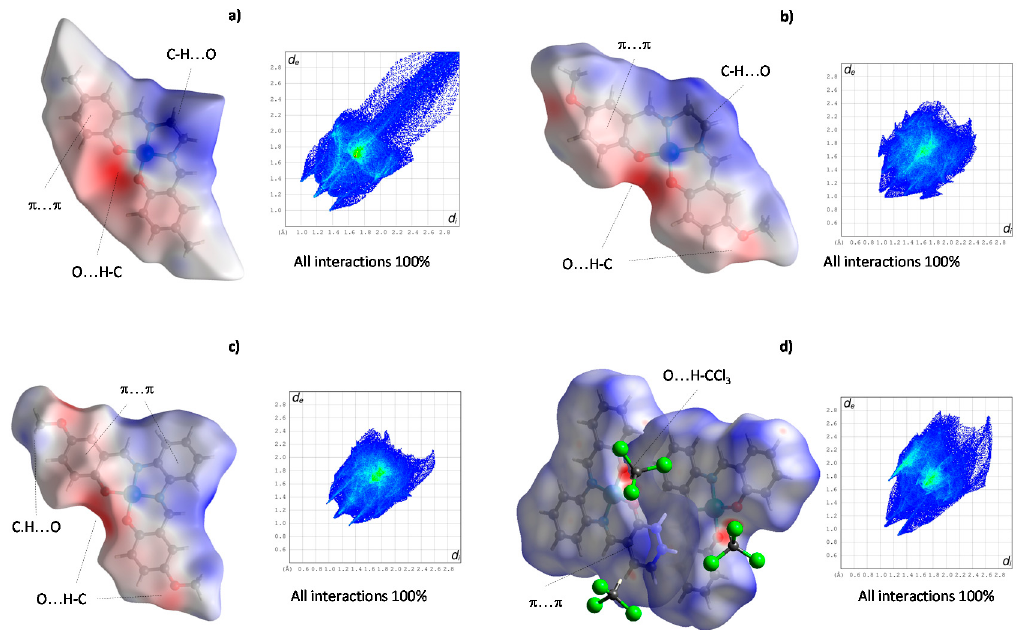
Figure 9. Hirshfeld surface (HS) with d norm mapped and fingerprinted plots of the compounds NiMe salen ( a ), NiMeO salen ( b ), NiMeO salphen ( c ), and Ni salphen ( d ) for all interactions.